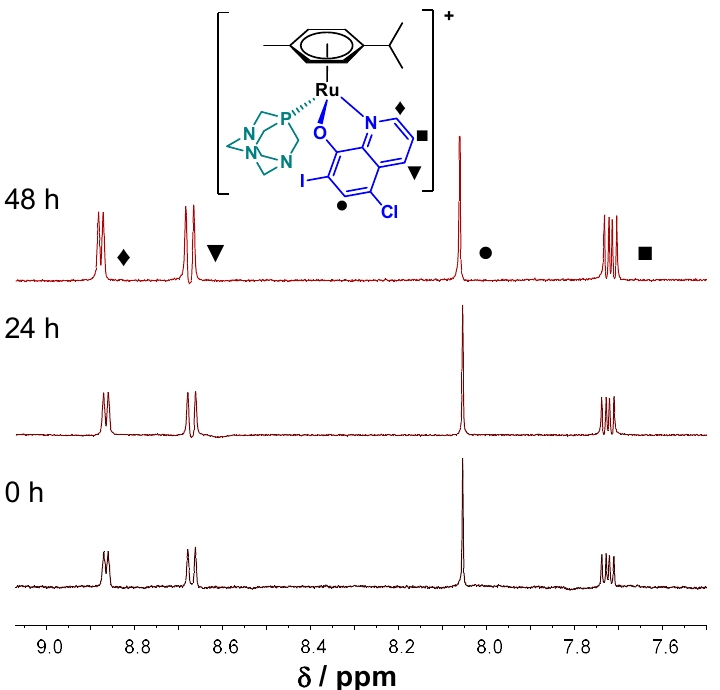
Figure 4. 1 H-NMR spectra of 6 at pH 7.4 (PBS’) in the low field region recorded for the fresh sample, after 24 h and 48 h waiting time. { T = 25.0 °C, c complex 6 = 0.5 mM; 10% ( v / v ) DMSO- d 6 }.